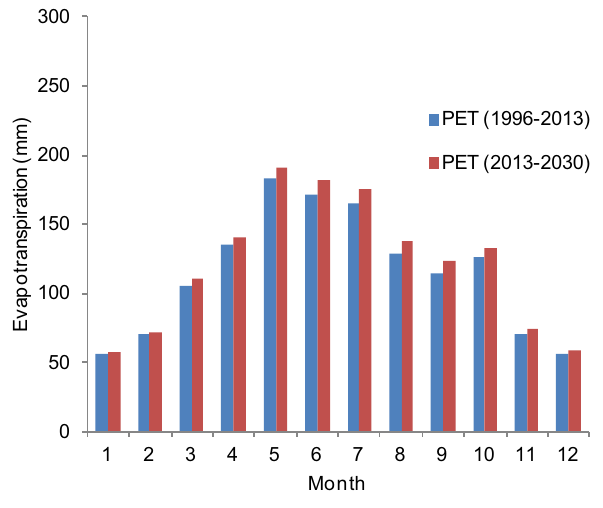
Fig. 13 Al Butum Wadi average monthly potential evapotranspiration